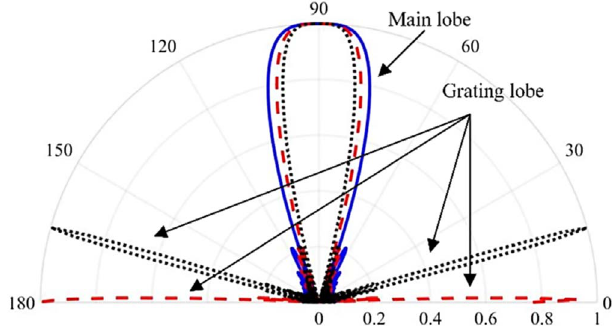
Figure 10. The directivity pattern of laser-induced ultrasonic array. The blue line, red line, black line represent a = 1 mm (< k ), a = 1.465 mm (= k ), a = 2 mm (> k ), respectively.